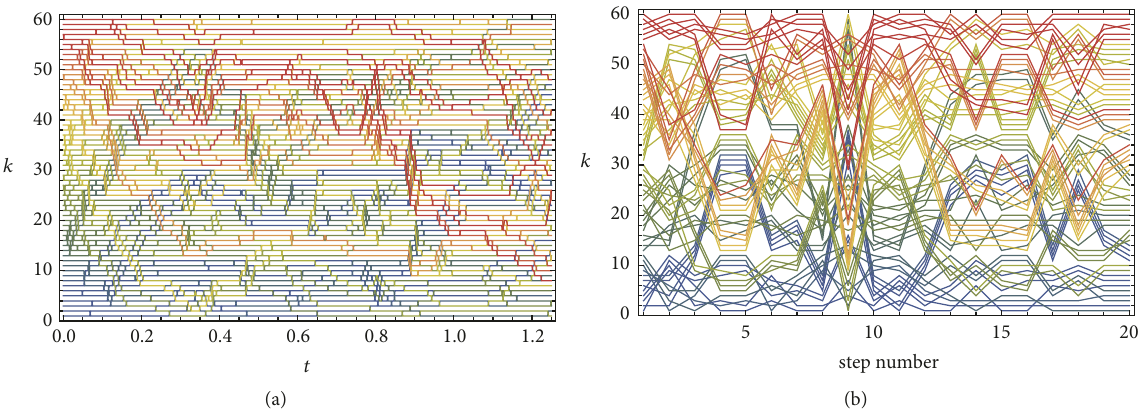
Figure 2: Time dependence of trajectory ranks . Time dependence of trajectory ranks for the models depicted in Figure 1(a), where particular instances of 𝑁 = 6 are considered. Colors are an aid to see how initial trajectory ranks diffuse over the 𝑘 axis as time goes by. We show results for the (a) bTSP, where trajectories spread slowly in time, and for the (b) TSP with reallocation of sites [rTSP], where there are drastic changes from one time step to another, as well as a tendency for keeping initially shorter/longer trajectories